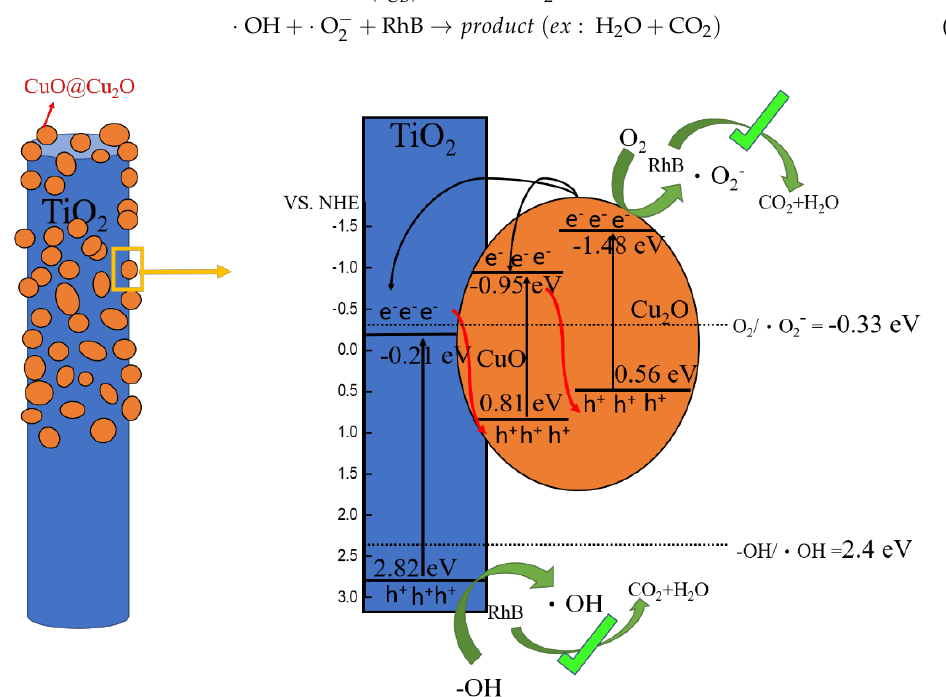
Figure 12. Possible mechanisms of charge transfer in TC350 under irradiation.